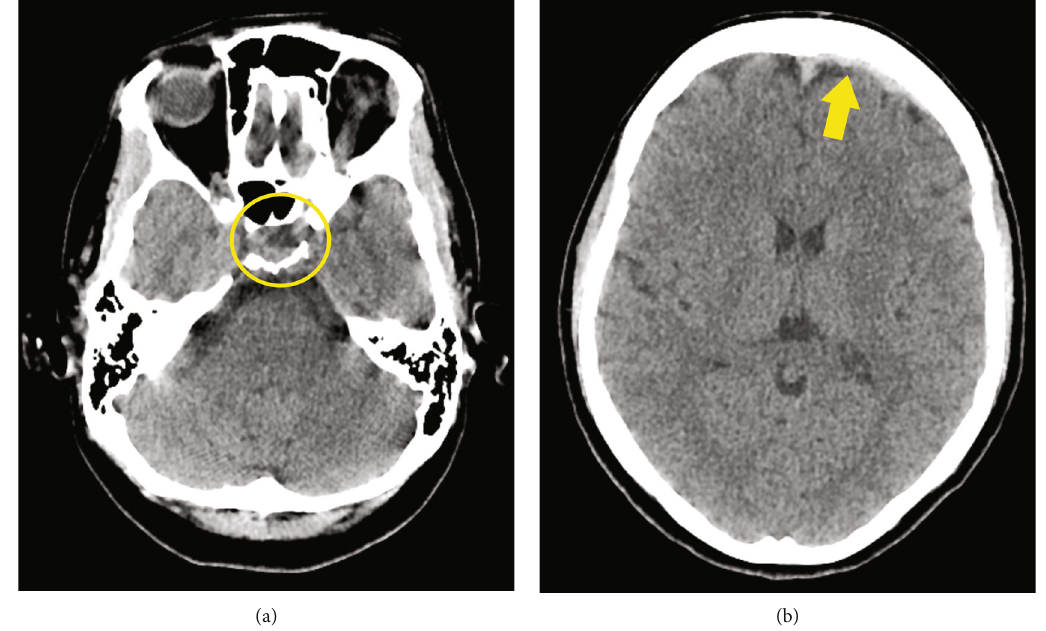
Figure 1: (a) Axial CT of pituitary apoplexy appearance indicates heterogeneous hyperattenuating intrasellar lesion due to the presence of hemorrhagic components with a fl uid debris level (circle). (b) Axial CT image shows a thin layer of acute subdural hematoma in the left frontal region (arrow).